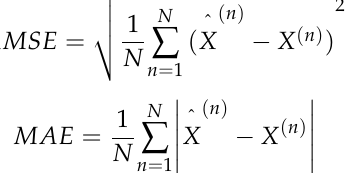
Table 2. The effect of adding reconstruction data during model